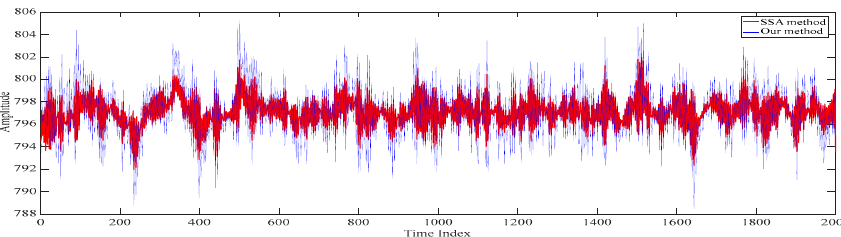
Figure 17. The reconstructed electroencephalograms obtained based on our proposed method and the conventional singular spectrum analysis-based method.